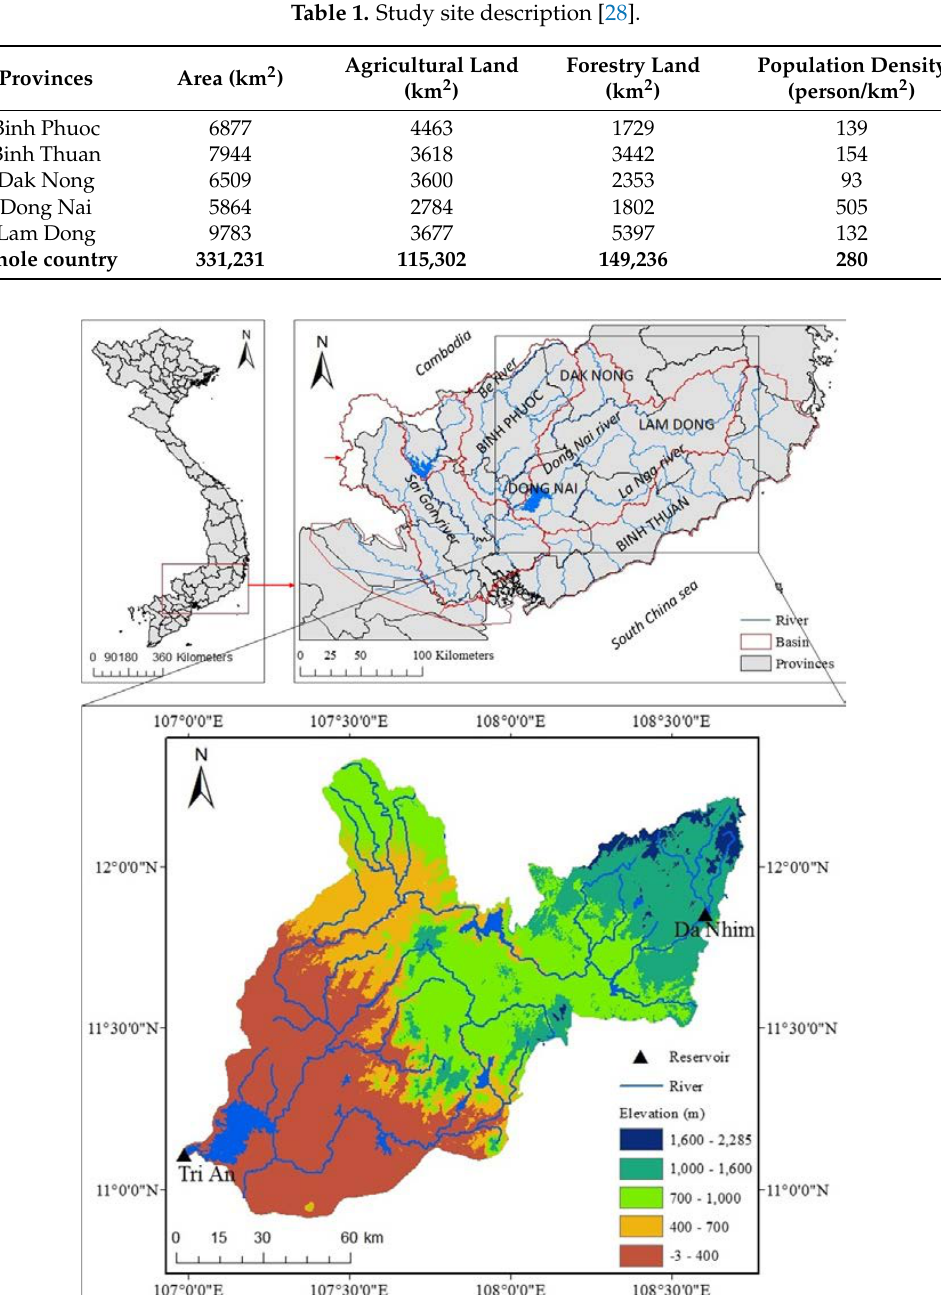
Figure 1. The upstream Dong Nai River Basin in Vietnam.